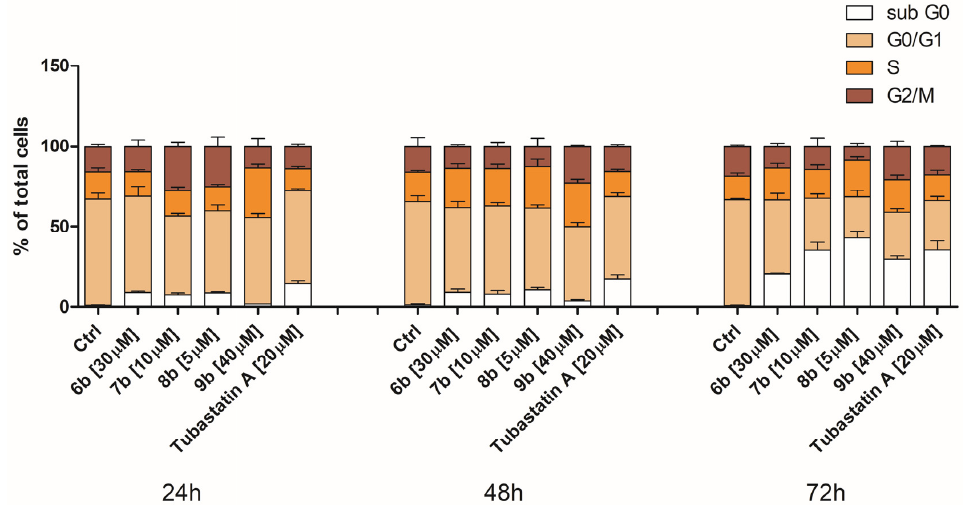
Figure 5. Changes in cell cycle phase distribution of MDA-MB-231 cells upon treatment with compounds 6b , 7b , 8b , 9b , and tubastatin A. After the 24 h, 48 h, and 72 h continual treatment of MDA-MB-231 cells with investigated compounds at IC 50 , as well as tubastatin A at IC 50 and 20 µM, cells were stained with propidium iodide and analyzed by flow cytometry. White bar—apoptotic cells with DNA content corresponding to sub-G1 fraction; sandy bar—cells with DNA content corresponding to G0/G1 phases; orange bar—cells with DNA content corresponding to S phase; maroon bar—cells with DNA content corresponding to G2/M phases (compared to the untreated control).